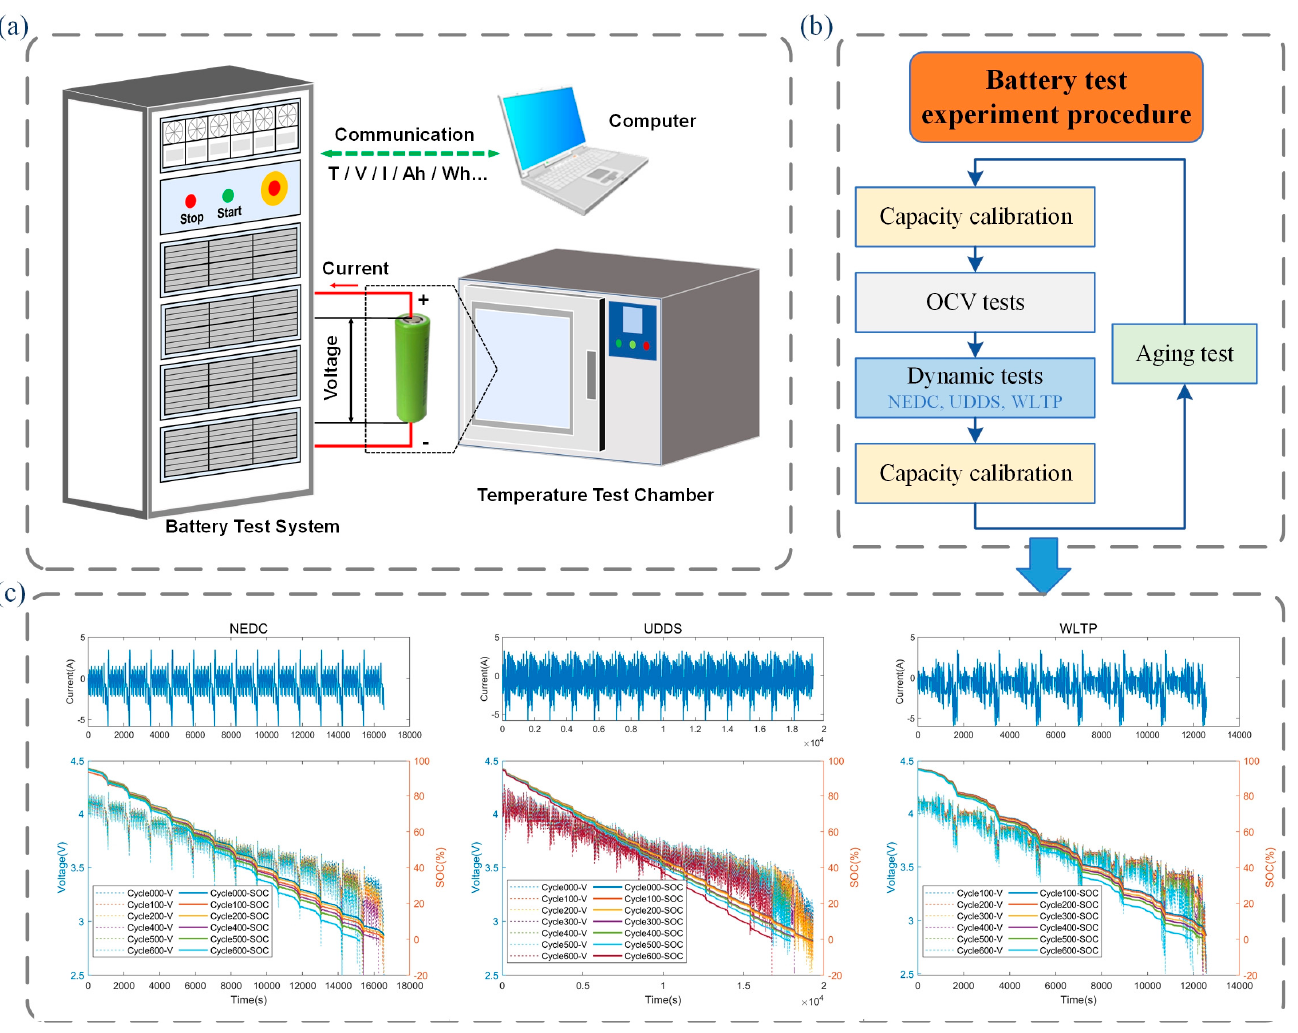
Figure 3. The battery test experiment: ( a ) battery test bench; ( b ) experimental scheme; ( c ) current, voltage, and SOC values of the test dataset of the target battery in three different dynamic conditions.